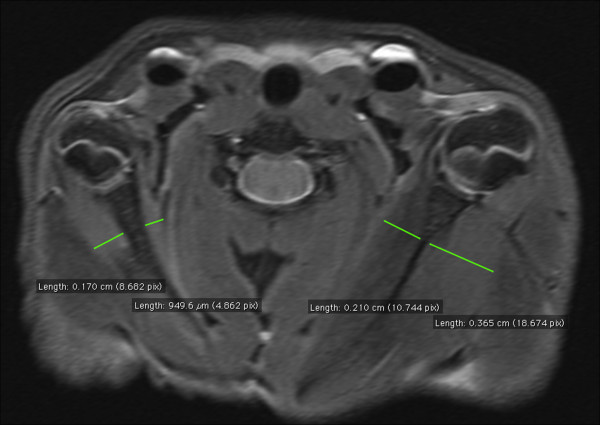
Shoulder MRI 8 weeks after surgery showing a marked atrophy of both infraspinatus and subscapular muscle that reproduces muscle changes found in children.